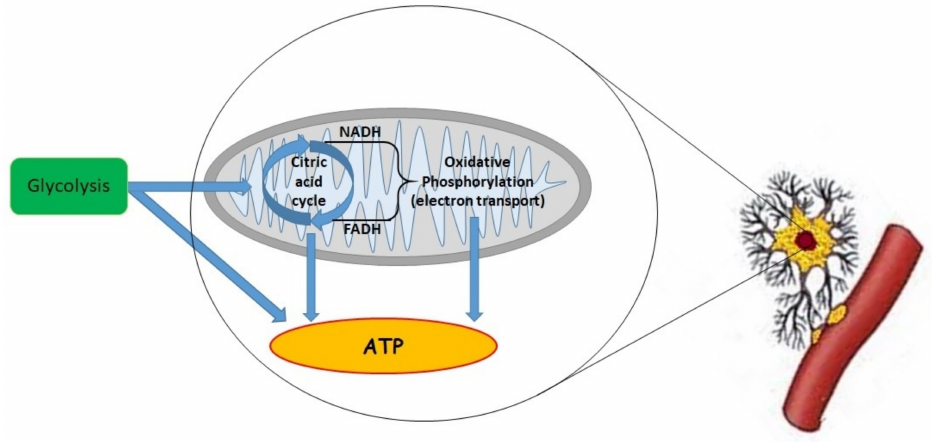
Figure 1. “Mitochondrial respiration” benefits when reducing nicotinamide adenine dinucleotide